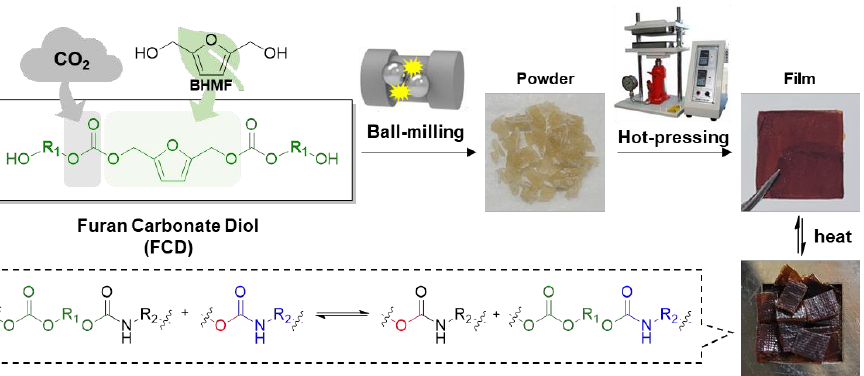
Figure 1. Synthesis of ecofriendly CO 2 -immobilized poly(carbonate-co-urethane) (PCU) networks and the preparation of the PCU films using a hot press.